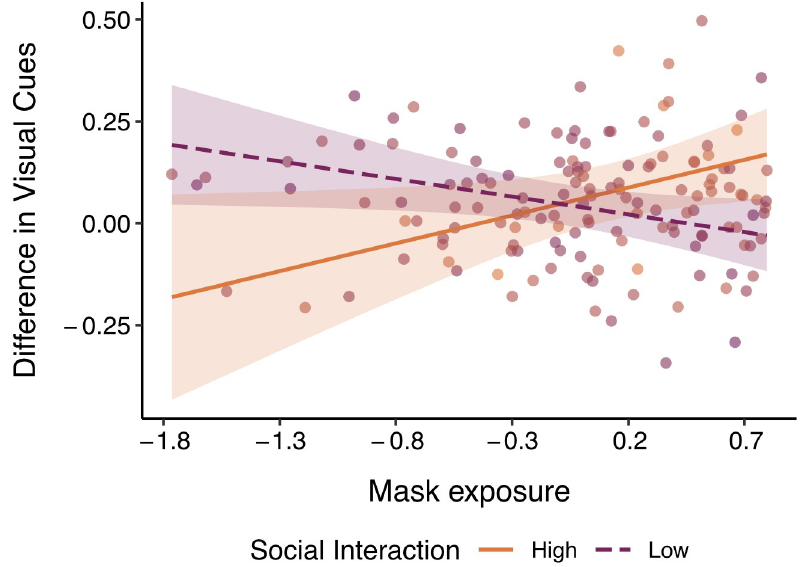
Fig 6. Effect of mask exposure on global visual cue use as a function of social interaction in Study 2. Social interaction mediated the relationship between mask exposure and visual cue use between time 1 and time 2. People with the least amount of social interaction had the greatest decrease in global visual cue use, and people with the most amount of social interaction had the greatest increase in use of global visual cues. Transparent bands reflect 95% confidence